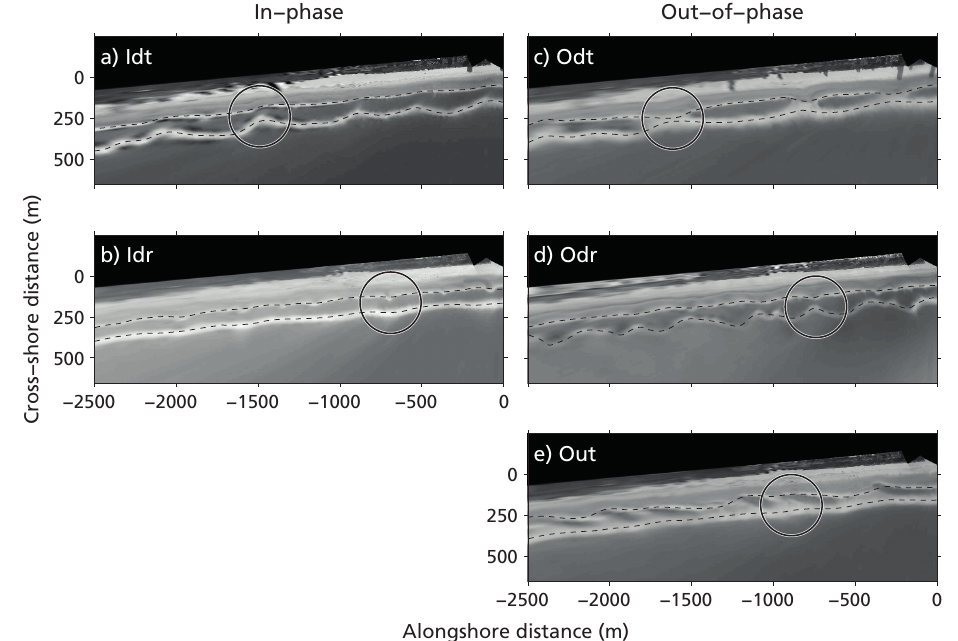
Figure 6. Examples of observed types of morphological coupling between the inner and outer barlines; low-tide time-exposure plan-view images of in-phase images with (a) an inner terrace and (b) inner rips, out-of-phase coupling with (c) an inner terrace and (d) inner rips in downstate direction, and (e) out-of-phase coupling with a clear alongshore offset between the inner- and outer-barline features in upstate direction. The dotted lines indicate the detected barlines, and the circles indicate a characteristic coupling feature for each coupling type. Source: Price and Ruessink (2013).